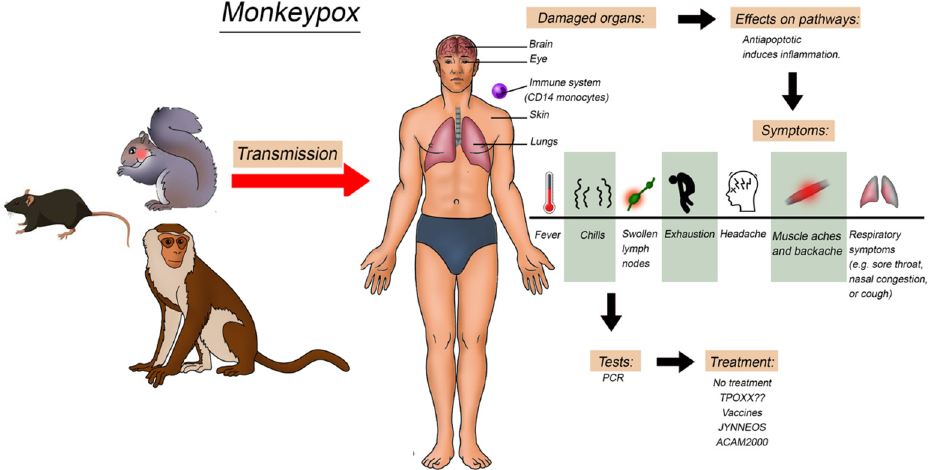
Figure 3. Illustration of the monkeypox transmission to humans and the effect on the different organs, symptoms, and pathways involved.